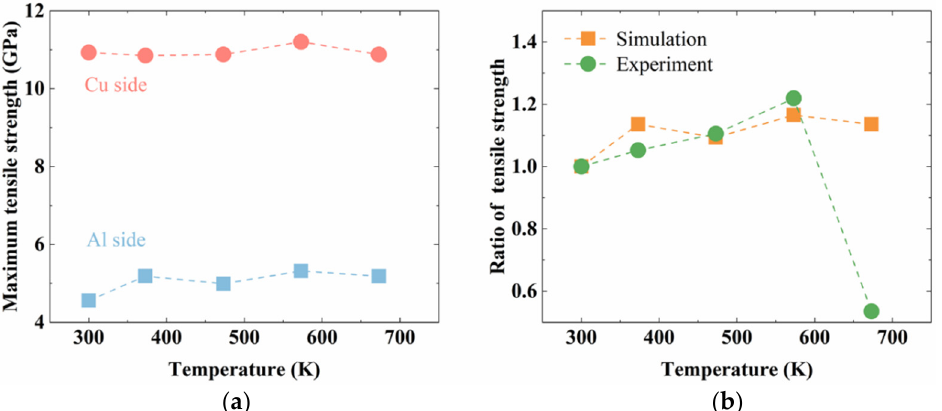
Figure 15. ( a ) The tensile strength of Cu–Al 4 Cu 9 structures, and Al 2 Cu–Al structures, and ( b ) the comparison between the simulated tensile strength ratio (strength of annealed structure over the strength of unannealed structure) and the experimental one.